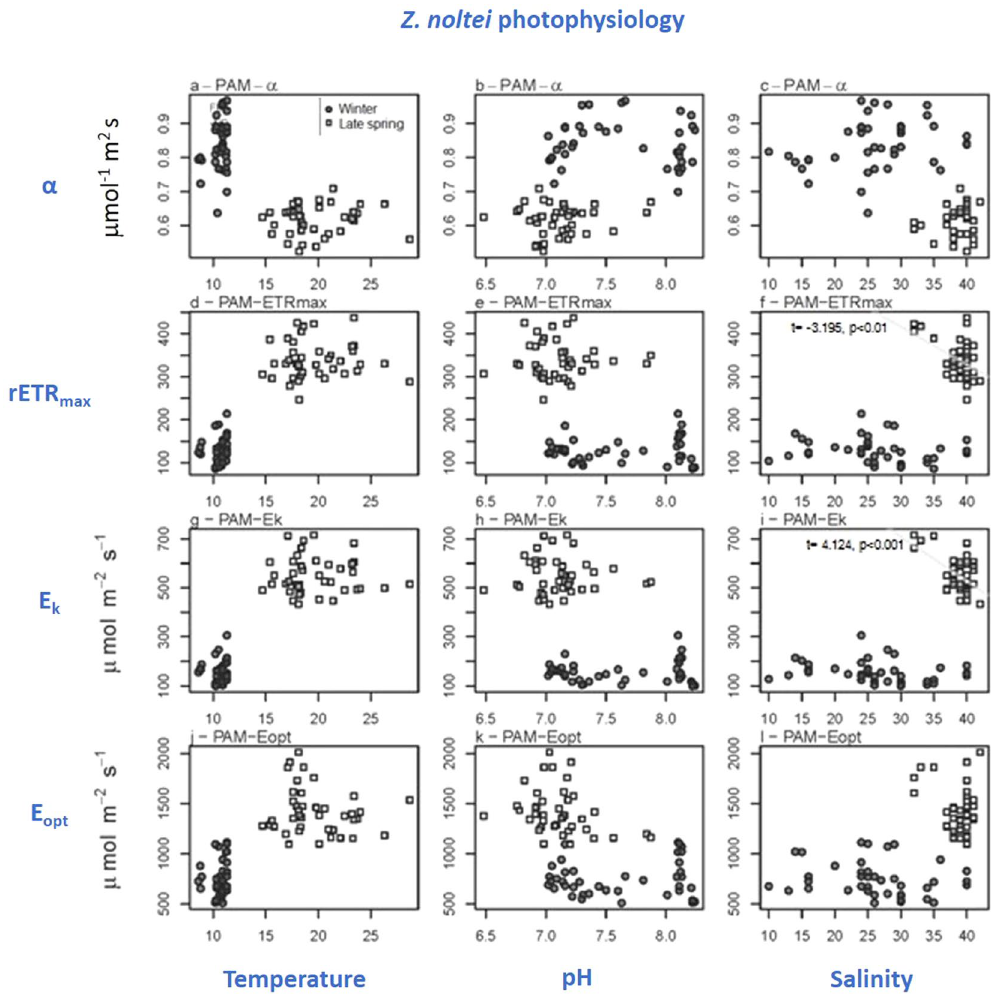
Figure 5. Z . noltei photosynthetic performance versus temperature, pH and salinity in winter and late spring. Maximum photosynthetic efficiency ( α ) versus ( a ) temperature, ( b ) pH and ( c ) salinity; maximum relative electron transport rate (rETR m ) versus ( d ) temperature, ( e ) pH and ( f ) salinity; photoacclimation index (E k ) versus ( g ) temperature, ( h ) pH and ( i ) salinity; optimum irradiance (E opt ) versus ( j ) temperature, ( k ) pH and ( l ) salinity. Statistical significant linear relationships within each season are shown (p < 0.05). All statistical results are shown as Supplementary information (Table